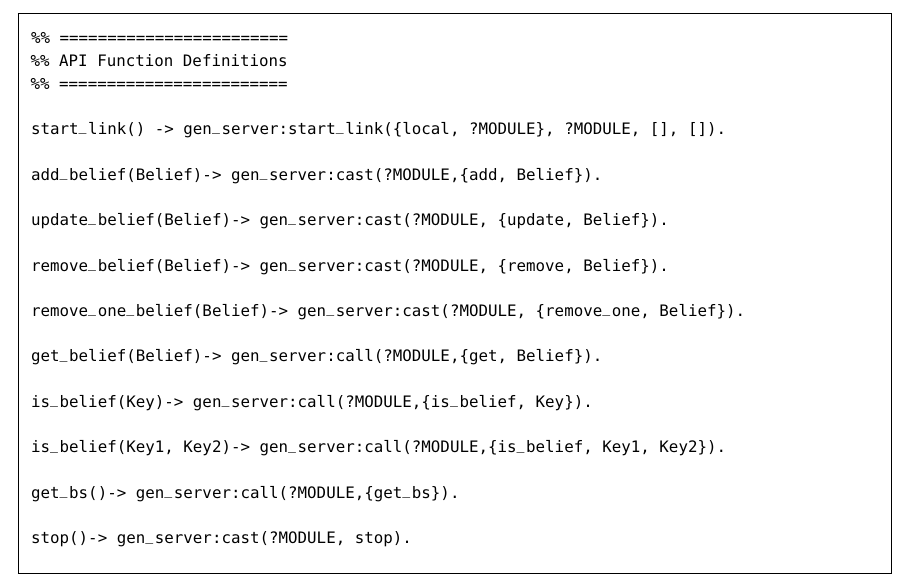
Table 12. API functions definitions for the BeliefStore module.